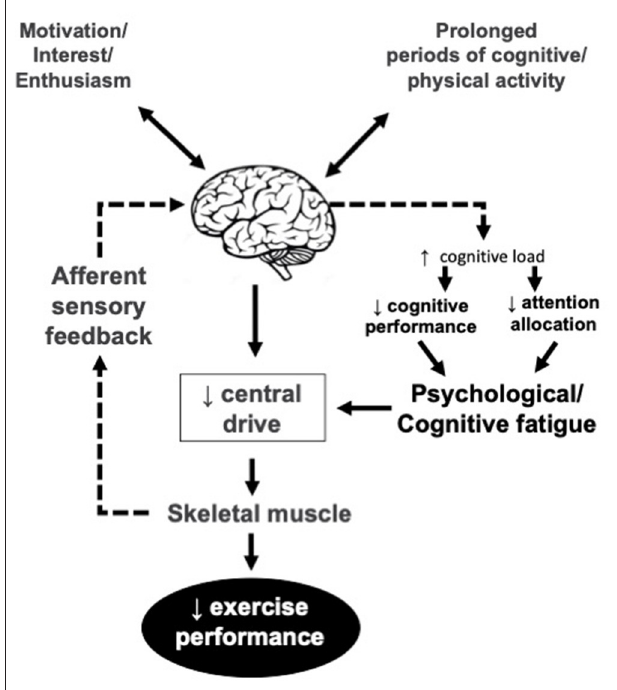
FIGURE 2 | Psychological/mental model of fatigue. Central drive is reduced due to lower motivation, interest and/or enthusiasm and lack of cognitive resources for the EP. The reduced enthusiasm may or may not be related to afferent sensory